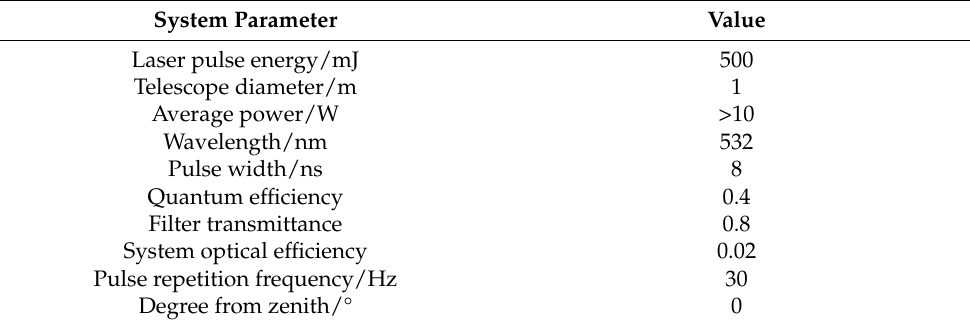
Table 7. Ground-based lidar